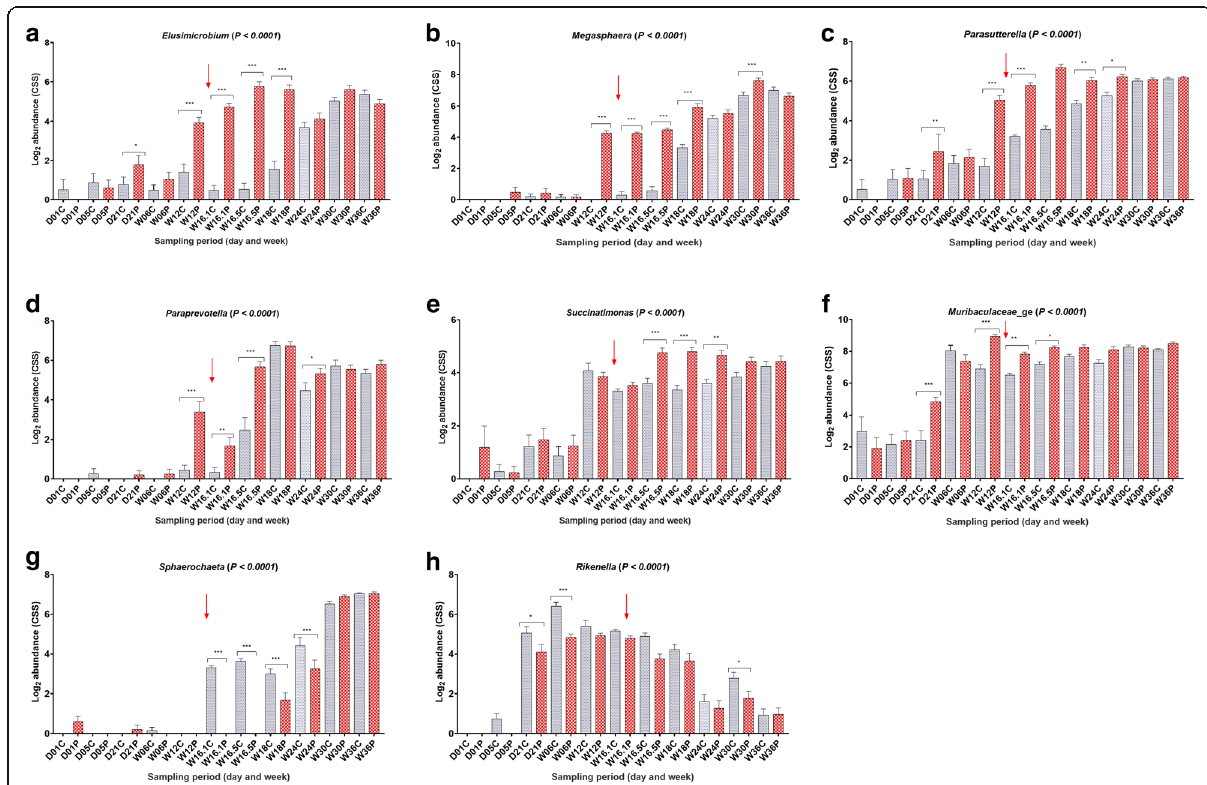
Fig. 4 Abundance of gut microbiota at genus level affected by probiotic supplementation at multiple sampling periods. a ). Elusimicrobium . b ). Megasphaera . c ). Parasutterella . d ). Paraprevotella . e ). Succinatimonas . f ). Sphaerochaeta . g ). Muribaculaceae _ge. h ). Rikenella . In each panel of Fig. 4, the letters “ D ” and “ W ” refer to day and week post-hatch, while the letters “ C ” and “ P ” refer to control and probiotic supplemented flocks, respectively. Asterisks (*, ** and ***) show P values at 0.01, 0.001 and 0.0001,